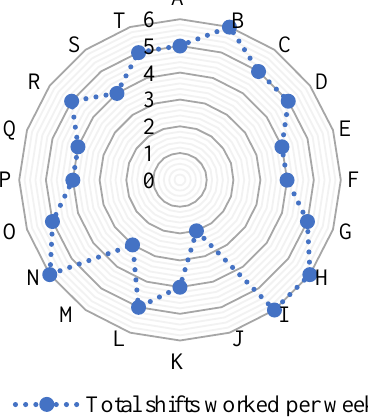
Figure 6. Total Shifts Worked Per